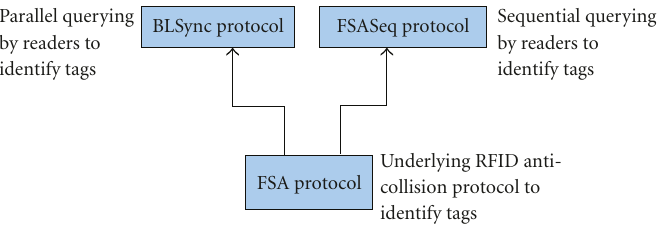
Figure 8: Relationships between the BLSync and FSASeq Protocols in terms of the FSA